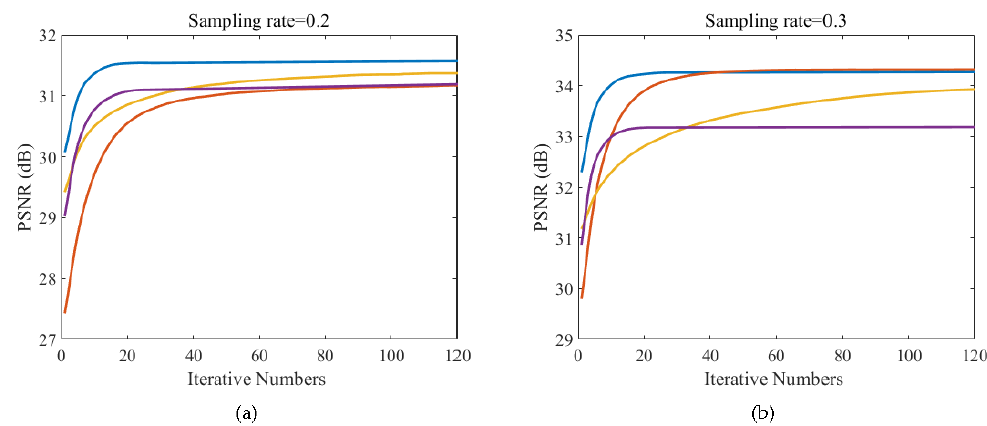
Figure 11. Evolutions of PSNR versus iteration number for four test images. ( a ) Sampling rate = 0.2; ( b ) Sampling rate =